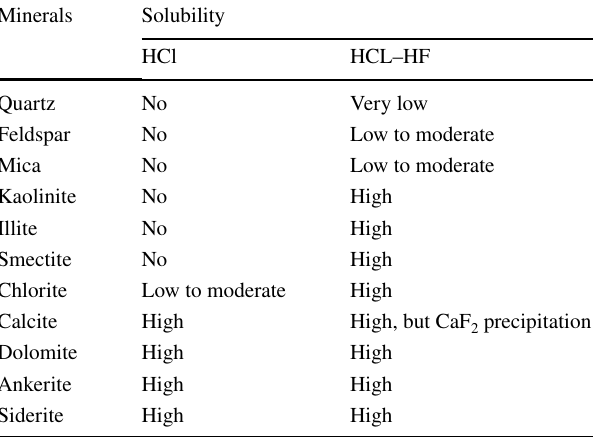
Table 2 Solubility of sandstone minerals (Portier et al.